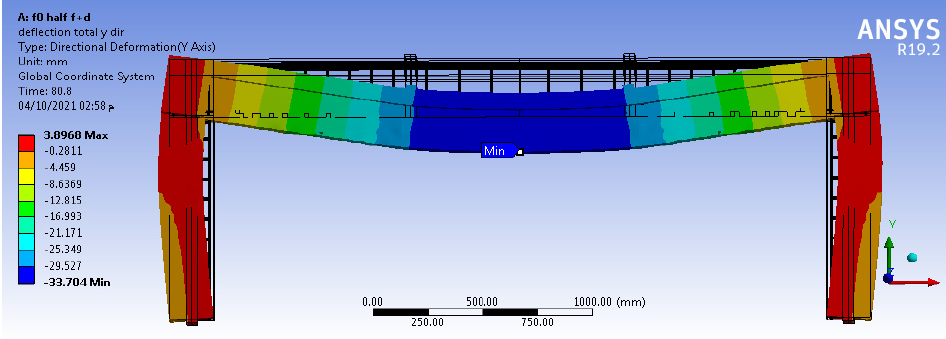
Figure 16. Deflection of sample F 0 at failure.